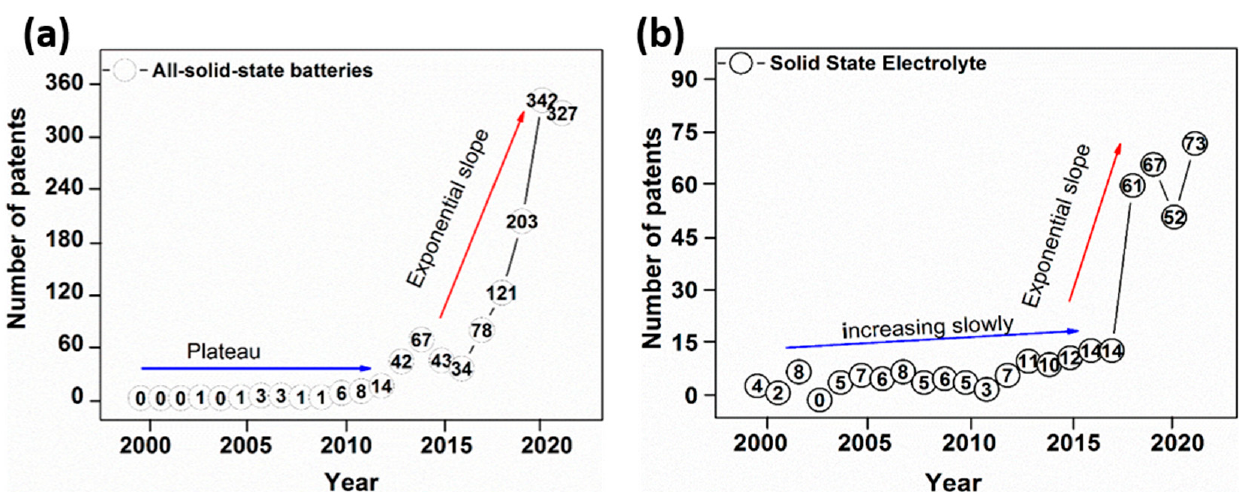
Figure 5. Patent applications on all-solid-state batteries ( a ) and solid-state electrolytes ( b ) published in the past two decades.